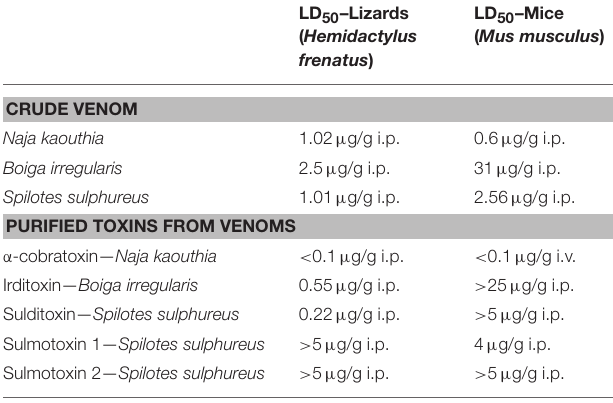
TABLE 1 | Toxicity of venoms and purified toxins toward lizards and mice.